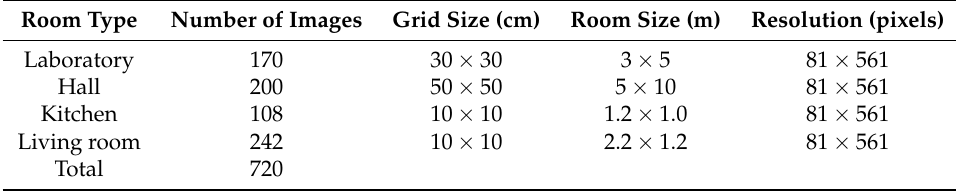
Table 2. Main features of the sets of images used to perform the